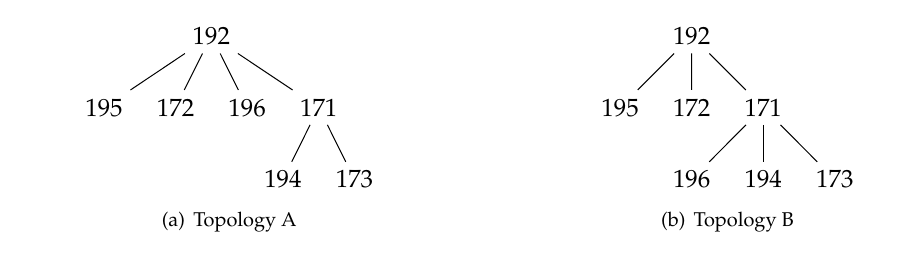
Figure 24. Loch Earn network topologies, A and B. A number of the channel impulse responses of packets transmitted from the sensor nodes, observed on a reference hydrophone close to node 192, are shown in Figure 25. Nodes 171–173 and 195 show a strong first arrival and relatively little multipath energy. Between runs these channels appear stable. Nodes 194 and 196 however show very weak multiple arrivals arriving at 192. Again, these channels are quite consistent across multiple runs.